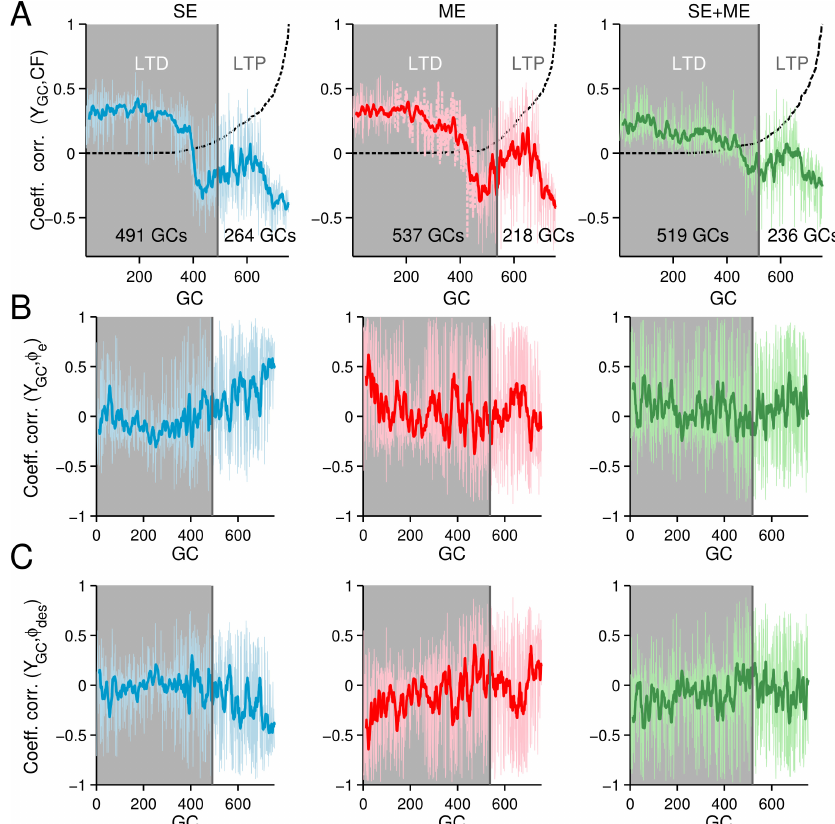
Figure 6. Correlation of granule cell (GCs) firing rate, climbing fiber (CF) and mossy fibers (MFs) in the CNN model. The granule cells in the x-axis have been sorted according to their W PF-PC value, so that at the origin is the most depressed and at x = 755 is the cell most potentiated during the control of the two-wheeled balancing robot. Shadowed areas show the granule cells depressed. The moving average ( N = 13) is shown in bold colors. The synaptic weight is shown with a dashed lined. ( A ) Coefficient of correlation between the CF and granule cells; ( B ) coefficient of correlation between the mossy fiber carrying wheel position error ( φ e ( t ) ) and the granule cells; ( C ) coefficient of correlation between the mossy fiber carrying desired wheel position ( φ des ( t ) ) and the granule